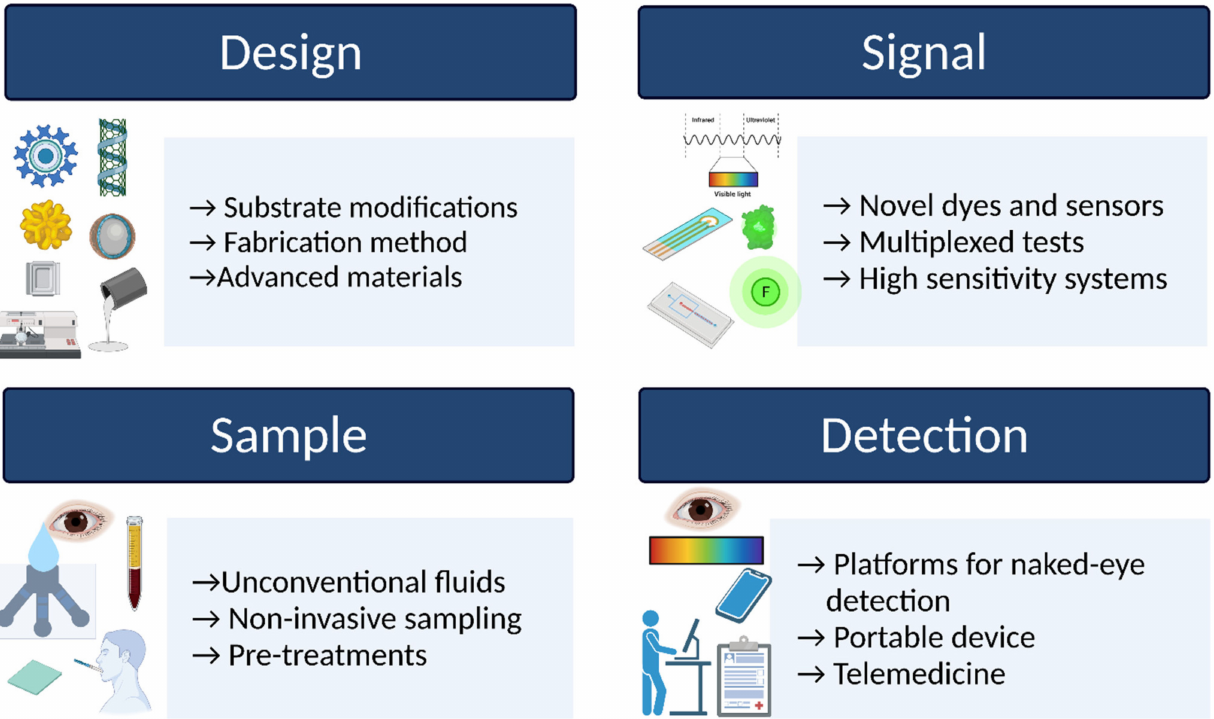
Figure 3. Opportunity and improvement areas for the development of paper-based platforms for type 2 diabetes diagnosis and monitoring. Created with